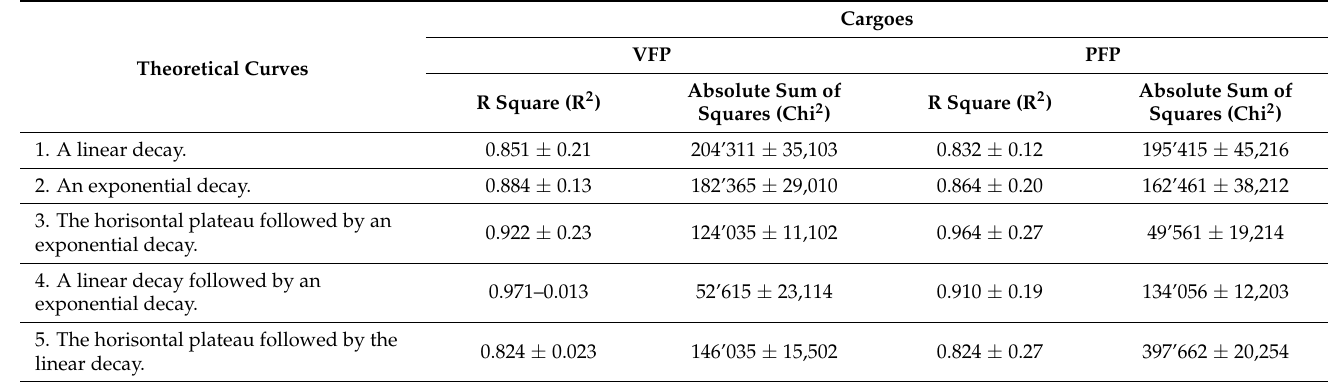
Table 5. Statistical evaluation of the goodness-of-fit of the regression lines obtained after synchroniza- tion of VFP and PFP exit from GZ according to the piFRAP protocol.